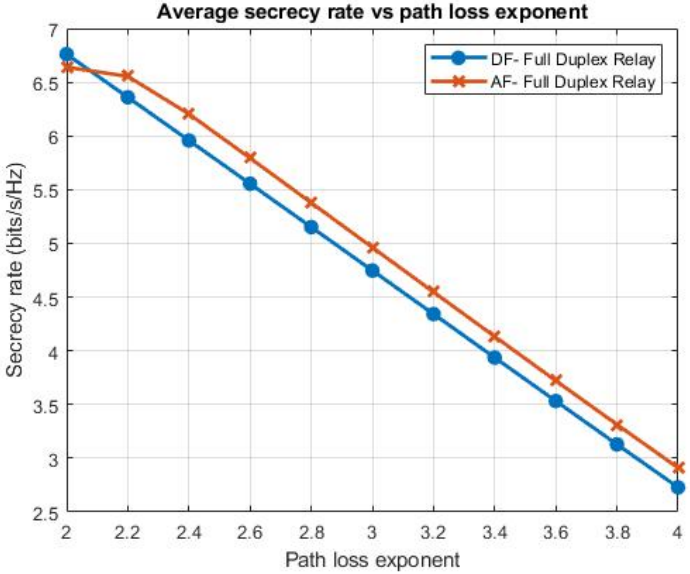
Figure 11. Secrecy Rate vs Path Loss Exponent for the EH System .